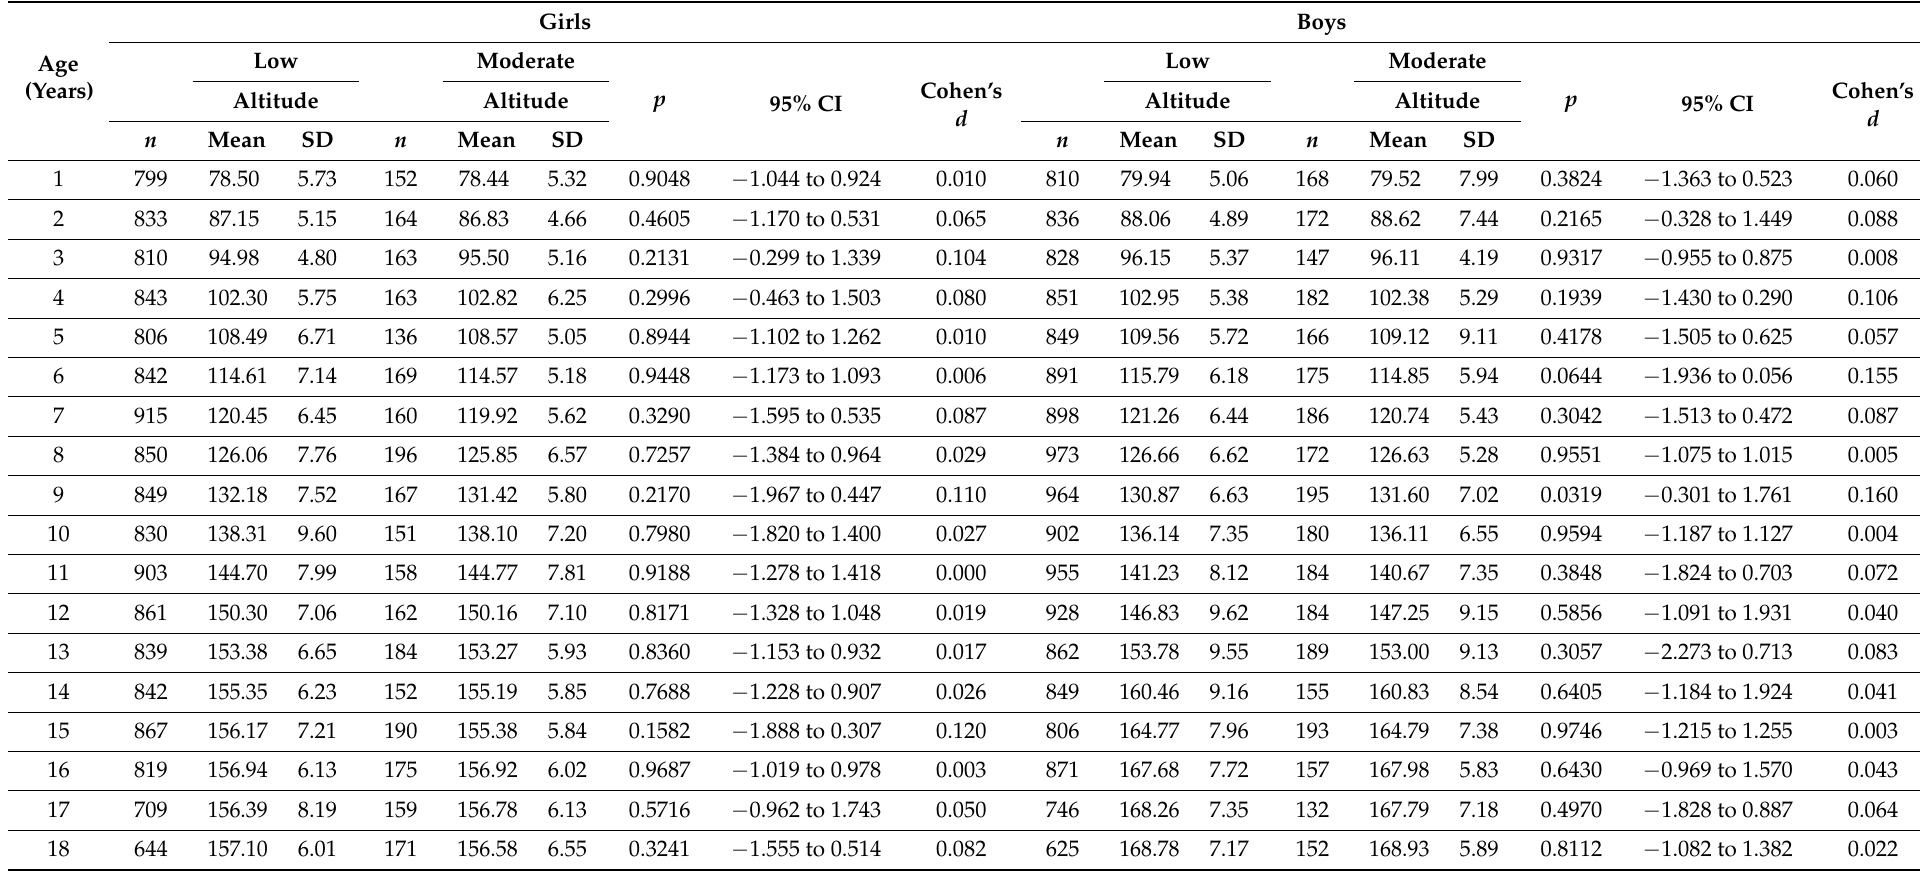
Table 1. Descriptive values (mean ± SD) of the heights of Colombian children and adolescents according to age, sex, and altitude